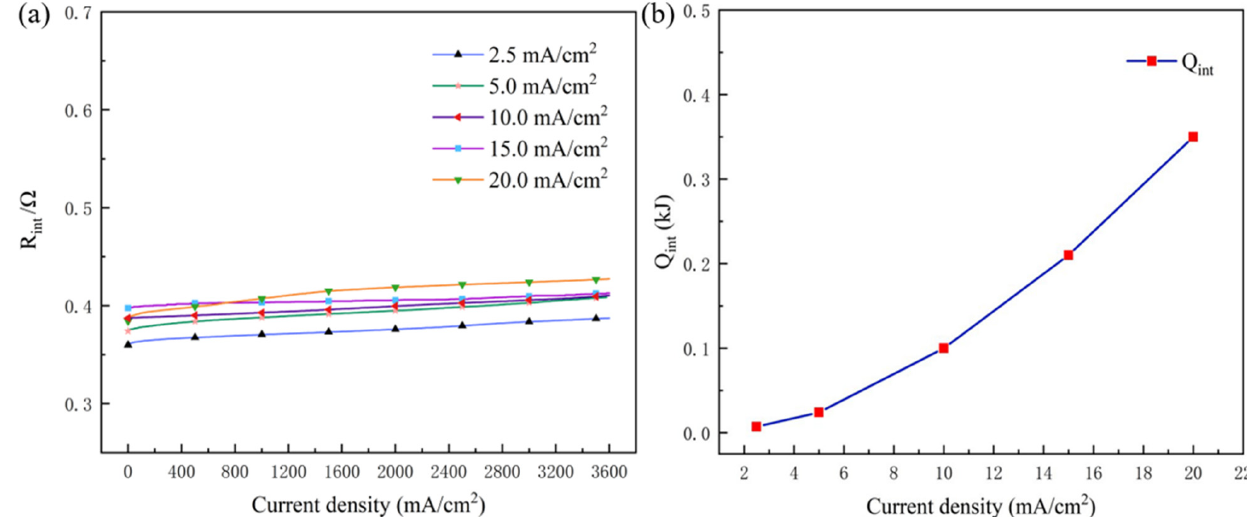
Figure 5. ( a ) R int for the aluminum–air battery at different current densities with discharge time and ( b ) Q int with different discharge current densities.